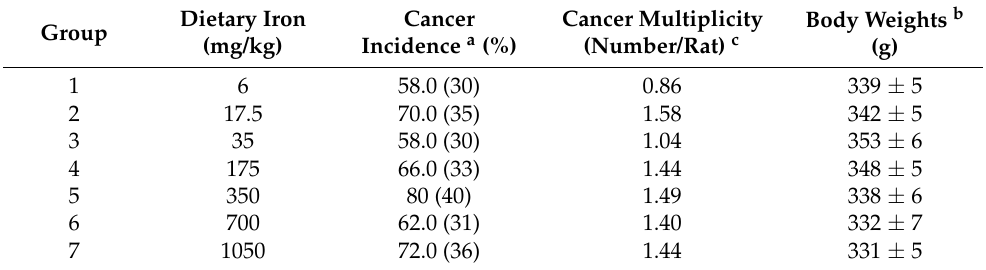
1050 72.0 (36) 1.44 331 ±